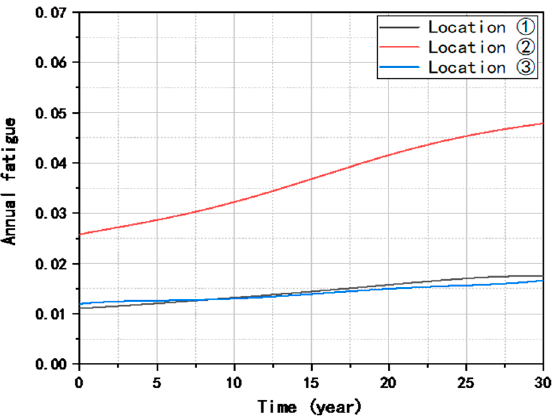
Figure 9. Accumulated fatigue damage of tubular joints under the combined loads obtained by the direct formula method.